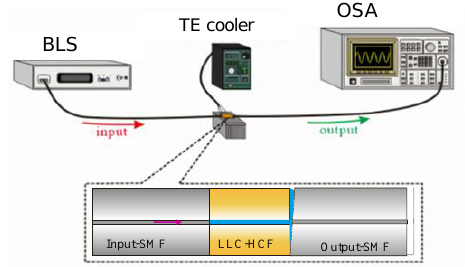
Figure 4. The schematic diagram of the measured system for the LLCFMZI.